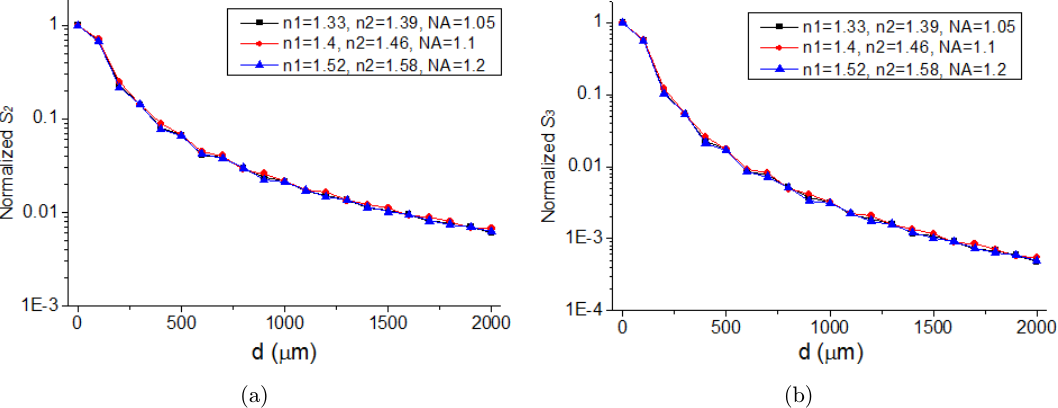
Fig. 6. Normalized (a) S 2 and (b) S 3 vs imaging depth for 1700-nm excitation but with di®erent immersion media and NAs. S 2 and S